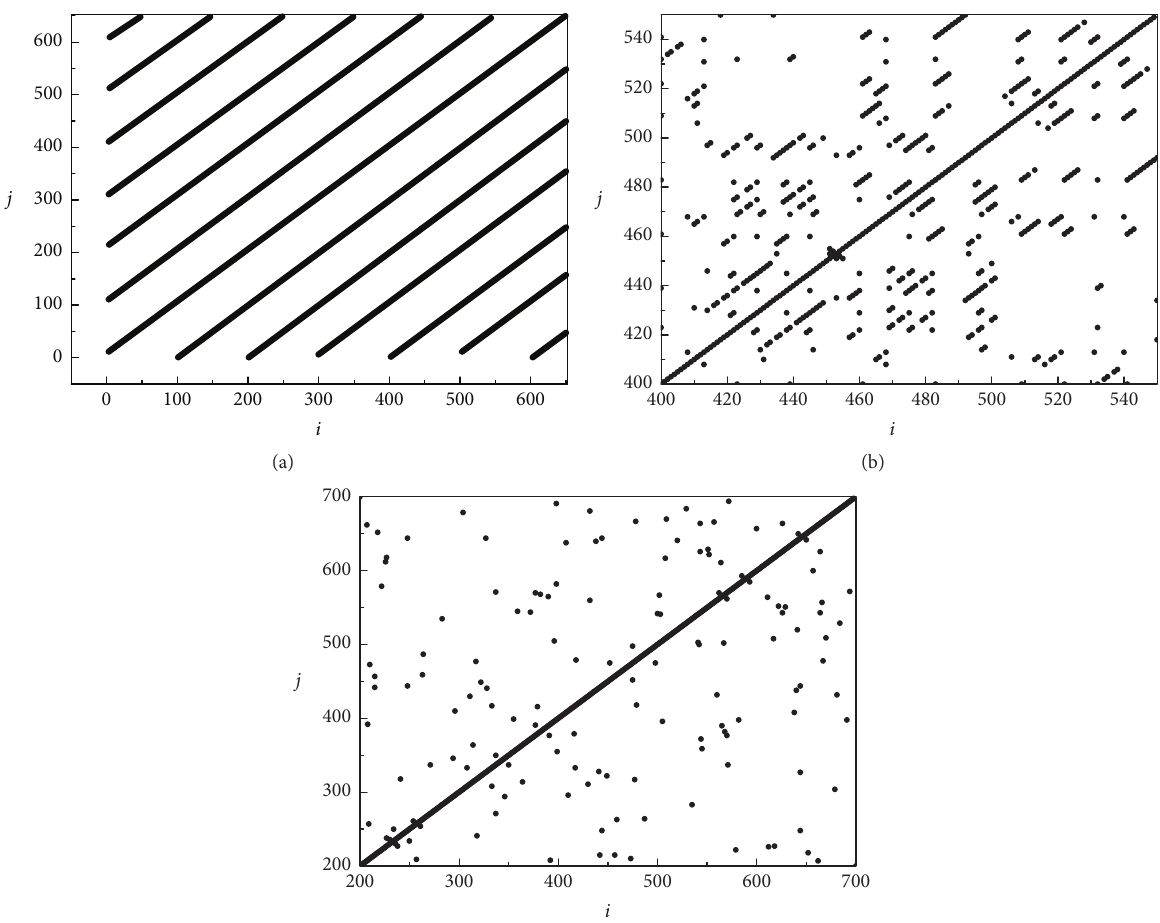
Figure 1: Recurrence plot of different dynamic systems: (a) periodic, (b) chaotic, and (c)